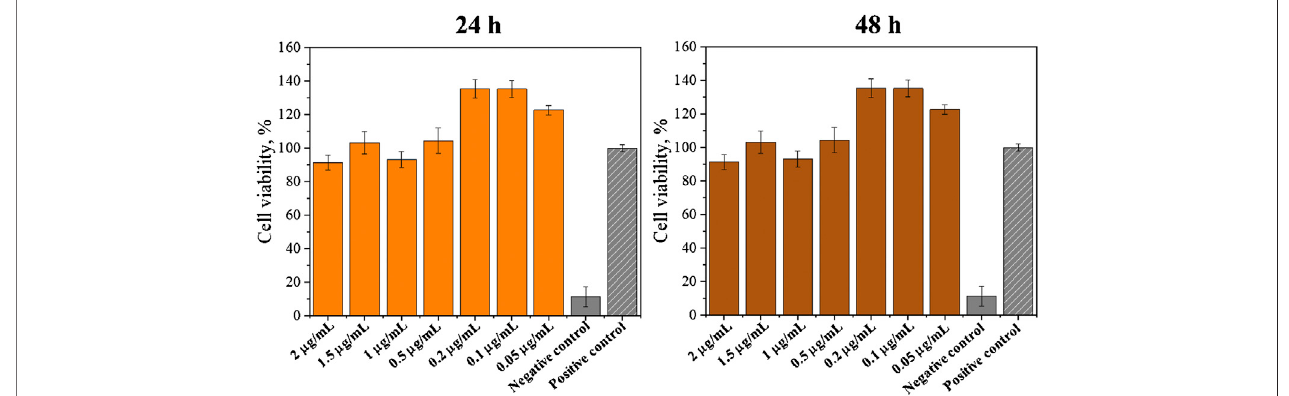
Frontiers in Bioengineering and Biotechnology |